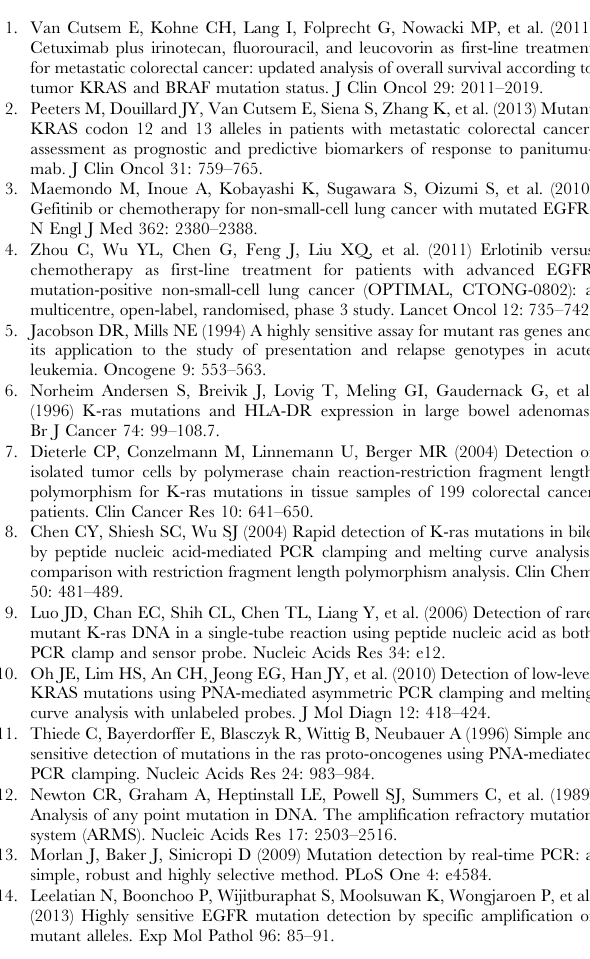
Table S1 Primers and probes used in real-time Bi-PAP. Table S2 Summary of the detection results of KRAS mutations in frozen tissue samples by different methods. Table S3 Summary of the detection results of EGFR mutations in frozen tissue and FFPE tissues detected by different